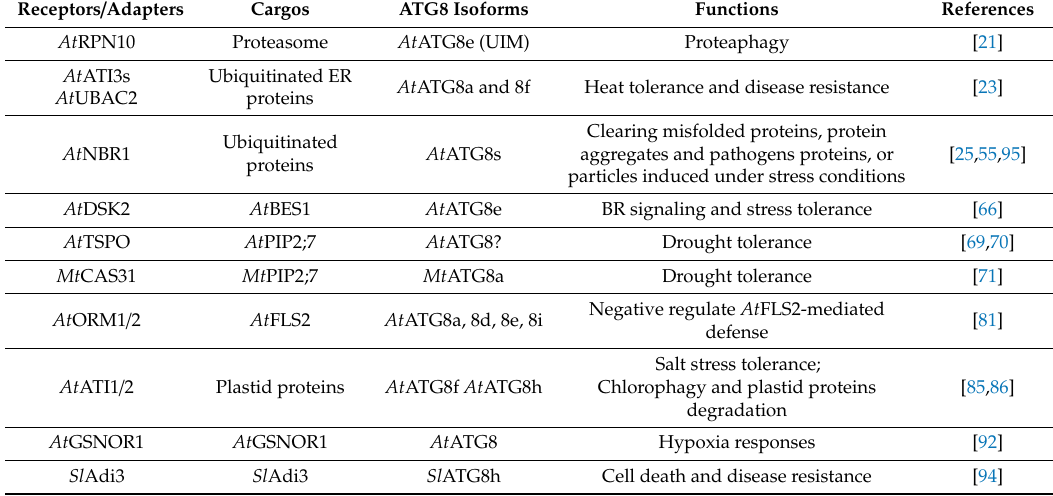
Table 1. The receptors and cargoes of selective autophagy and their functions in